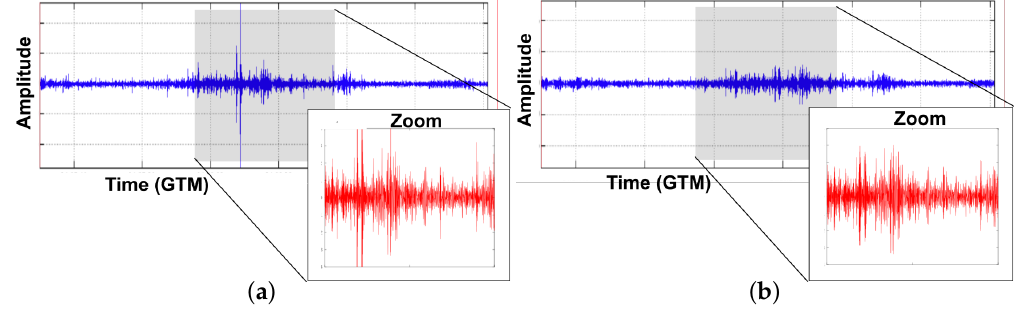
Figure 10. Signal preparation example. ( a ) Raw seismic data sensed by a sensor node. High picks represent possible events that obscure ambient noise. ( b ) Data after preparation preserving ambient